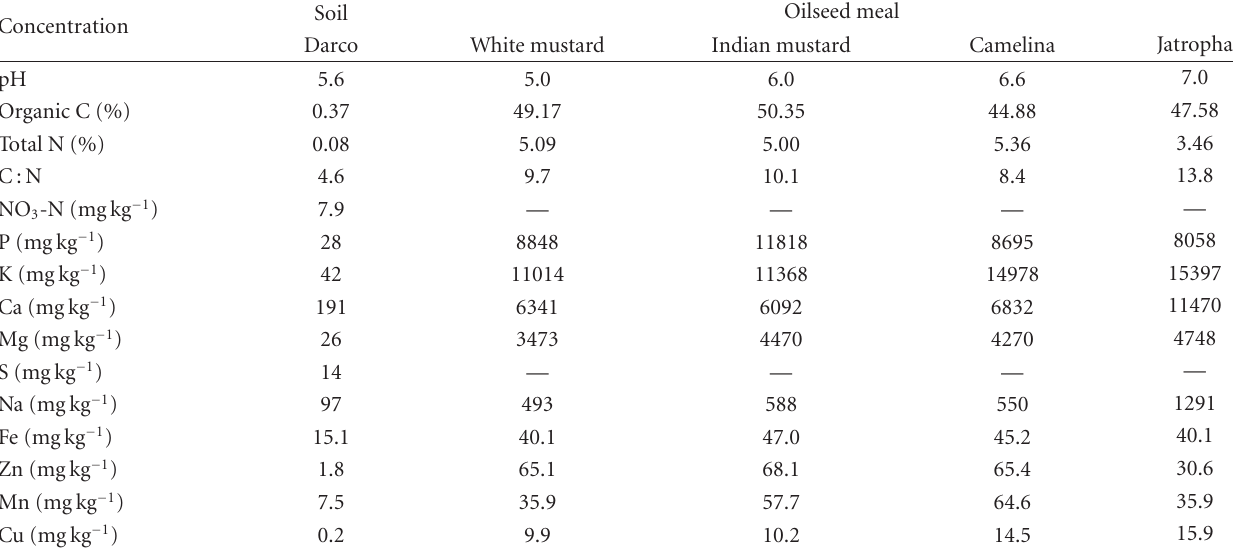
Table 1: Total nutrient concentrations of oilseed meals and total C and N and extractable nutrients in Darco soil. Soil Oilseed meal Concentration Darco White mustard Indian mustard Camelina pH Organic C (%)